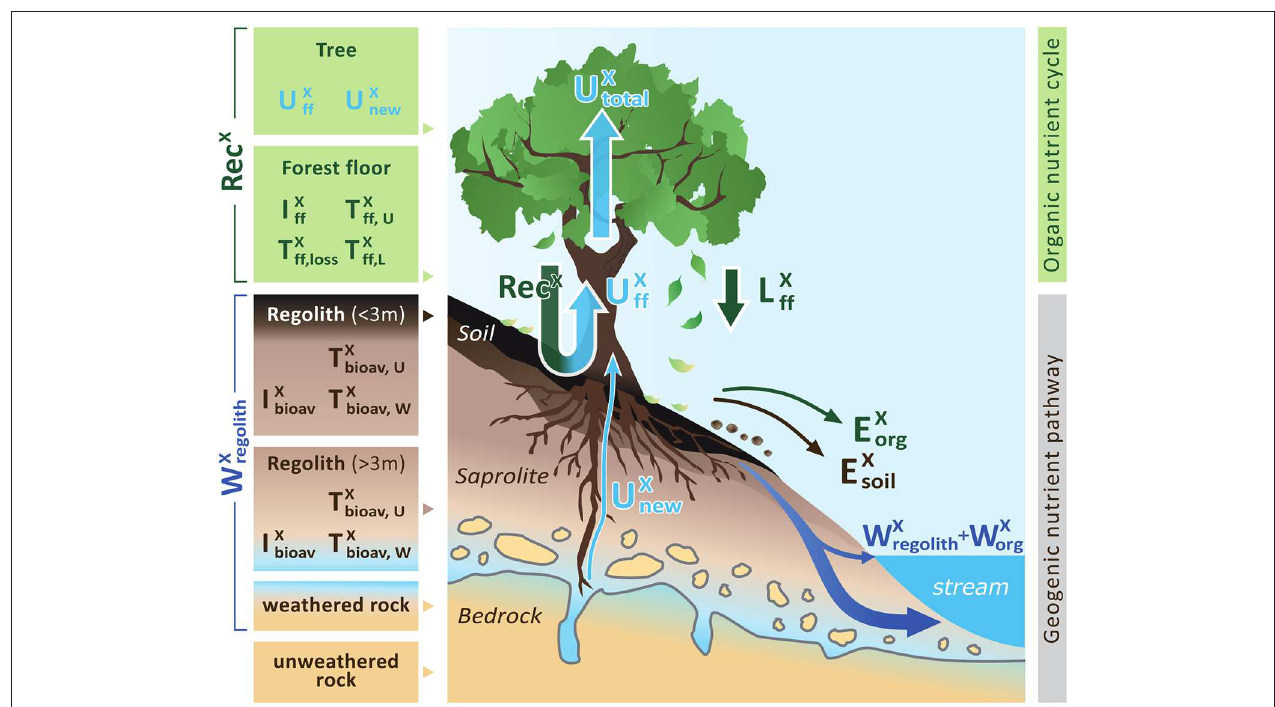
FIGURE 1 | A conceptual forest ecosystem comprising the “geogenic nutrient cycle” which is mainly effected by nutrient release through chemical weathering ( W X regolith ) and the “organic nutrient pathway” which is mainly effected by nutrient re-utilization (recycling) from organic matter ( Rec X ). Individual compartments are presented as boxes including the metrics used to quantify their properties: nutrient inventory (I) and nutrient turnover time (T) of element X. The first subscript refers to the ecosystem compartment (“ff” denotes forest floor, “bioav” denotes the biologically available fraction and “regolith” denotes soil, saprolite and weathered rock, respectively). The second subscript refers to the flux used to calculate the respective turnover time (“U” denotes nutrient uptake, “L” denotes litterfall, “W” denotes chemical weathering). Compartments are linked by fluxes (arrows), where the thickness of the arrows indicates the relative proportions. Fluxes include nutrient uptake (U), chemical weathering (W), erosion (E) of soil or organic matter (org), and litterfall (L). “Rec” denotes nutrient recycling. Detailed information on the metrics is provided in Table 1 . Figure is not drawn to